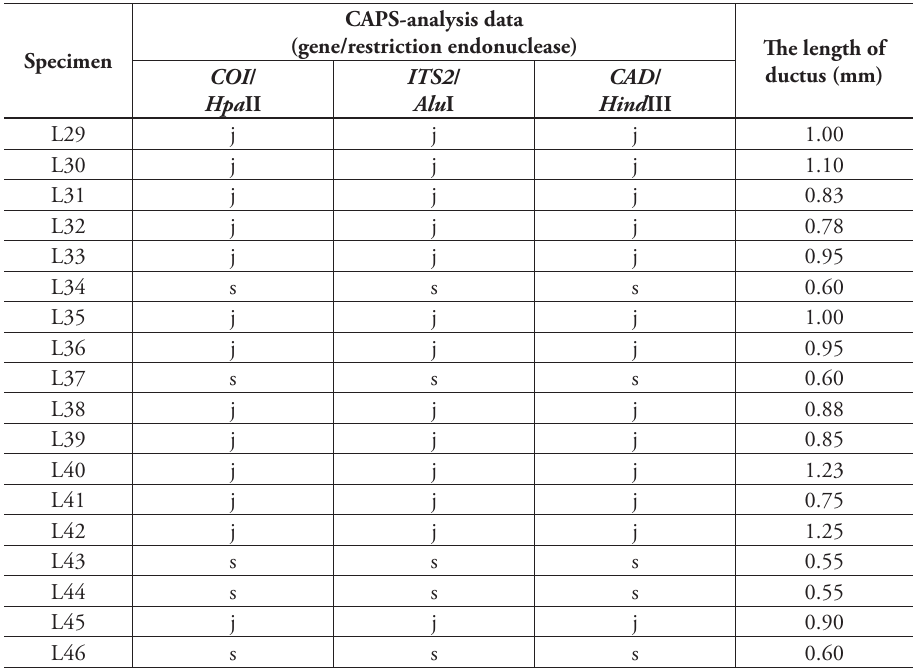
Table 6. CAPS-analysis data and the lengths of the ductus in females of L. sinapis and L. juvernica .